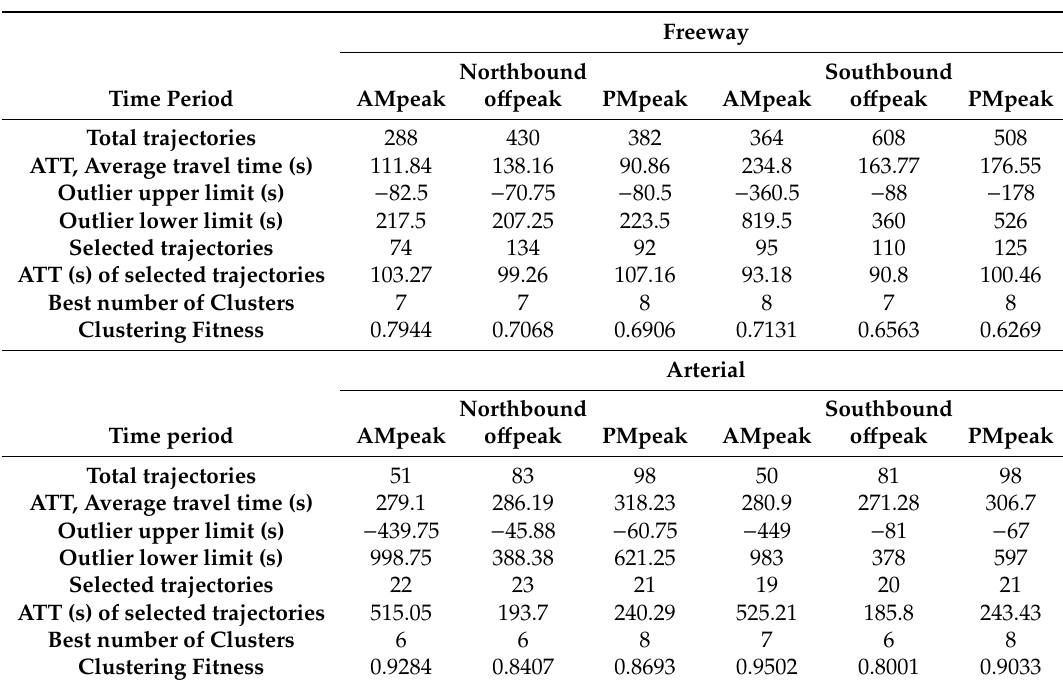
Table 2. Summary of trajectory